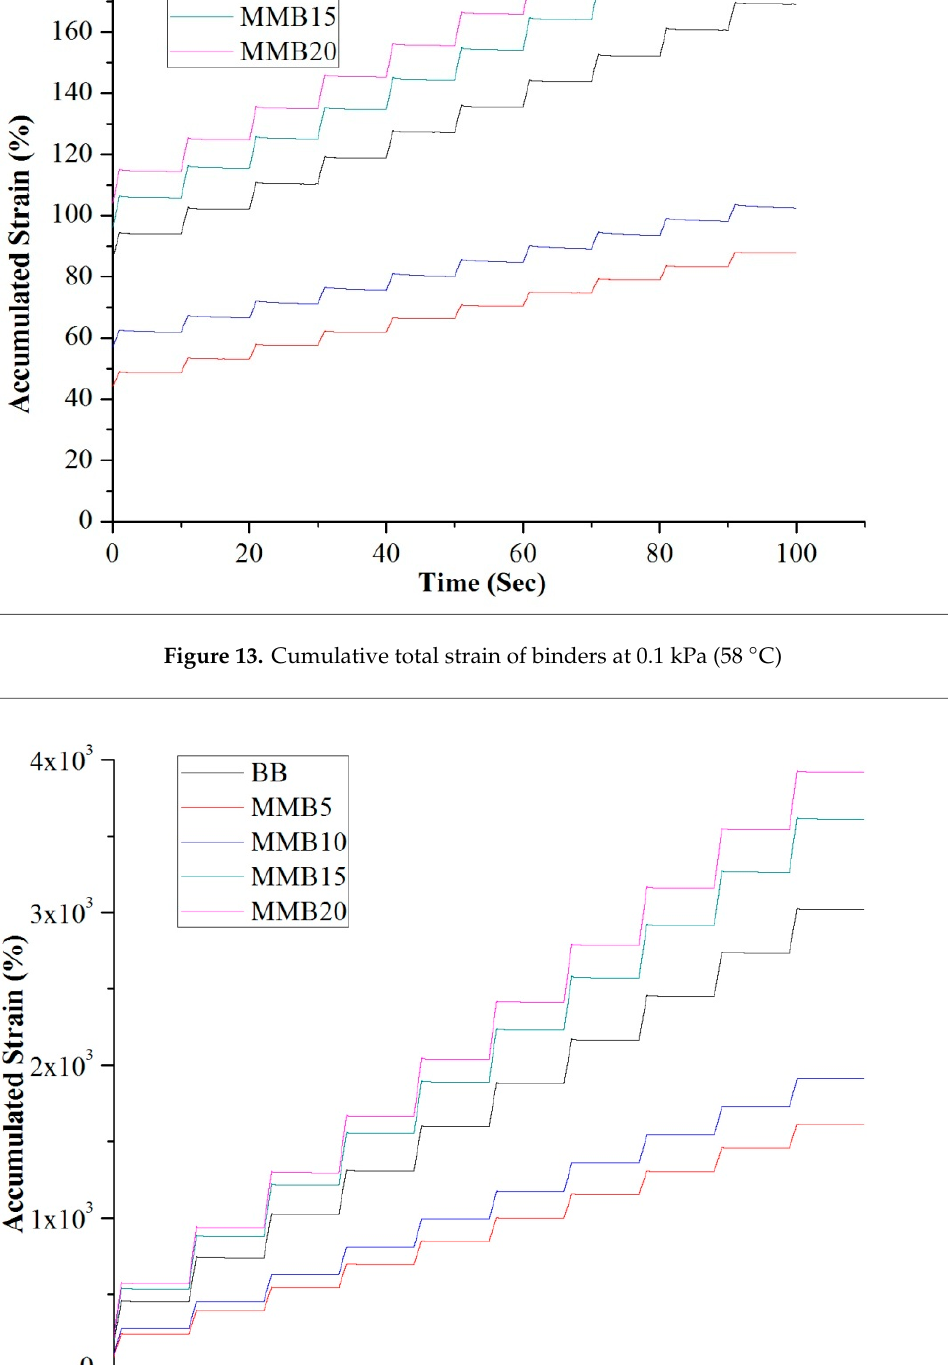
Figure 14. Cumulative total strain of binders at 3.2kPa (58°C)